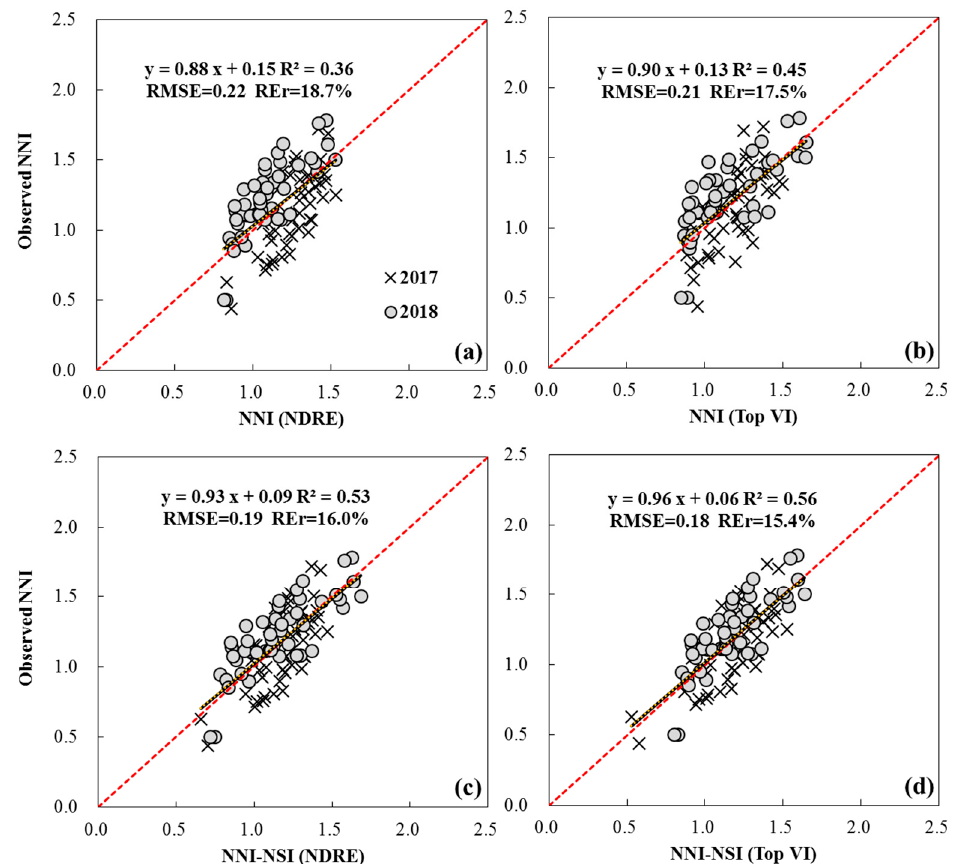
Figure 5. Validation results of nitrogen nutrition index (NNI) for two di ff erent direct nitrogen status diagnostic approaches (NNI in a and b; NNI-NSI in c and d) using the optimal estimation model of NDRE ( a ), NSI_NDRE ( c ), the top vegetation index (TNDGR in b ), and the top N su ffi ciency index (NSI) calculated from vegetation index (NSI_REWDRVI in d ) across varieties and years. Black lines indicate the regression line, and red dotted lines indicate the 1:1 lines.